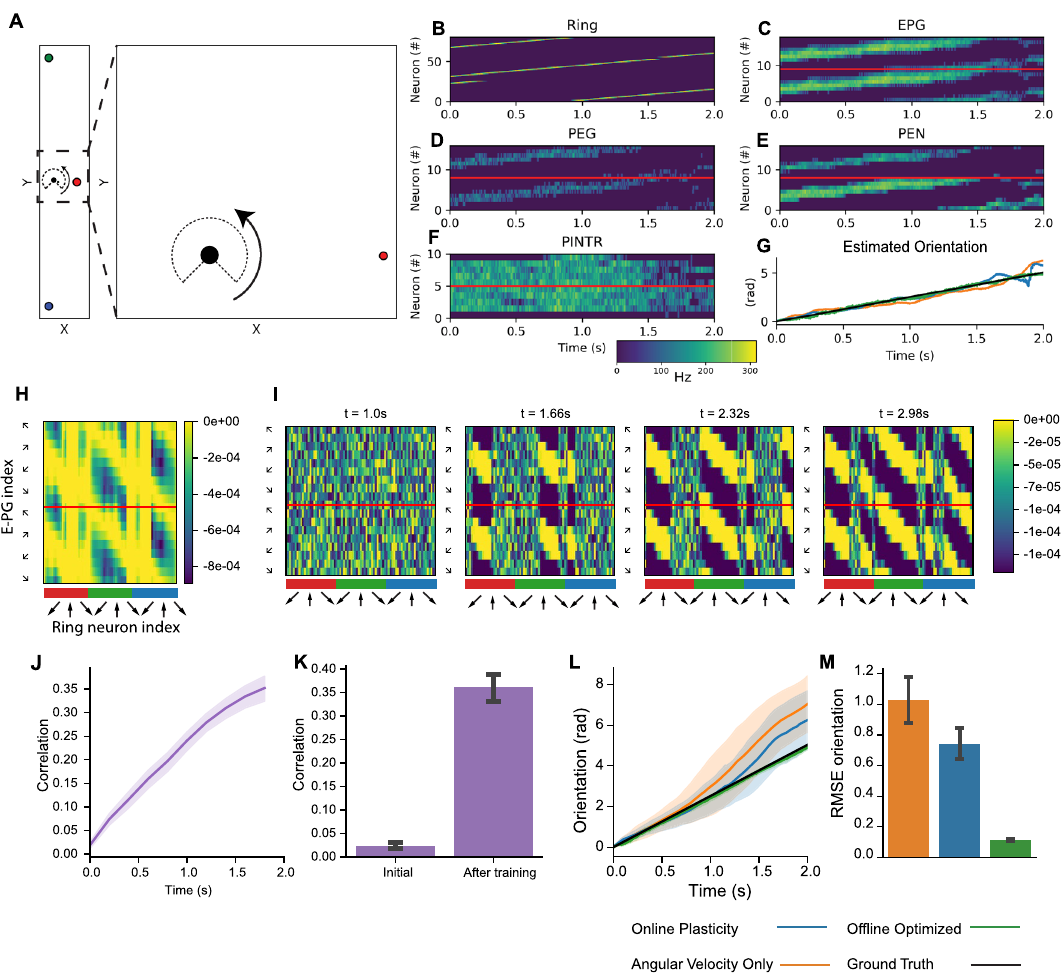
Figure 2. Sensor fusion and online learning with rotation in simulation. ( A ) Visual and angular velocity inputs to network correspond to a rotation in a simulated environment with landmarks and a 270° field of view. ( B – F ) Neuron activation over time in each population supports sensor fusion of inputs into an activity bump that shifts in the E-PG neuron population during rotation. (G) Orientation estimation decoded from E-PG neuron activity (best seed example) with evaluated model configurations tracks the ground truth orientation. ( H ) r → c Offline optimized W specifies an optimal mapping from visual landmarks encoded in ring neurons to E-PG “compass” neuron activation. Ring neuron indices are arranged sequentially according to receptive field center for each colored landmark. ( I ) In the model configuration with online plasticity, weights evolve over time to a similar structure as offline optimized weights. ( J – K ) Correlation between online learned weights and the offline optimized solution increases over time. ( L ) Estimated orientation over time drifts less with online plasticity then with angular velocity alone. ( M ) Average orientation RMSE. All group level analyses in ( J – M ) are performed for 50 simulated seeds. ( J, K, M ) have 95% bootstrapped confidence bounds, ( L ) has standard deviation confidence